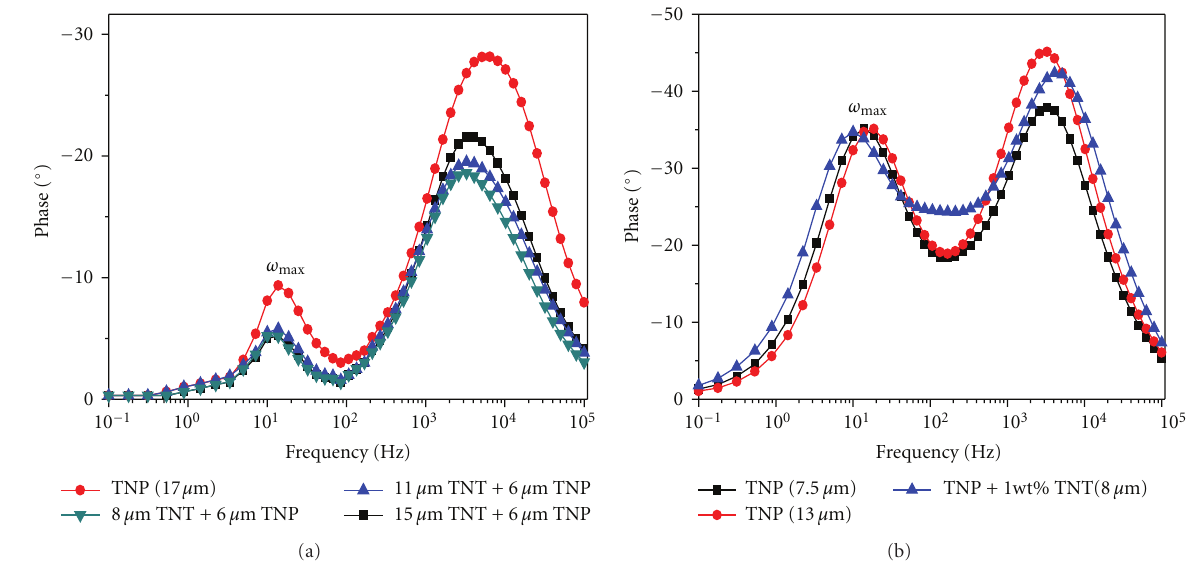
Figure 6: Bode plots from electrochemical impedance measurement of DSSCs under dark conditions of (a) cell type-A, and (b) cell type- B.